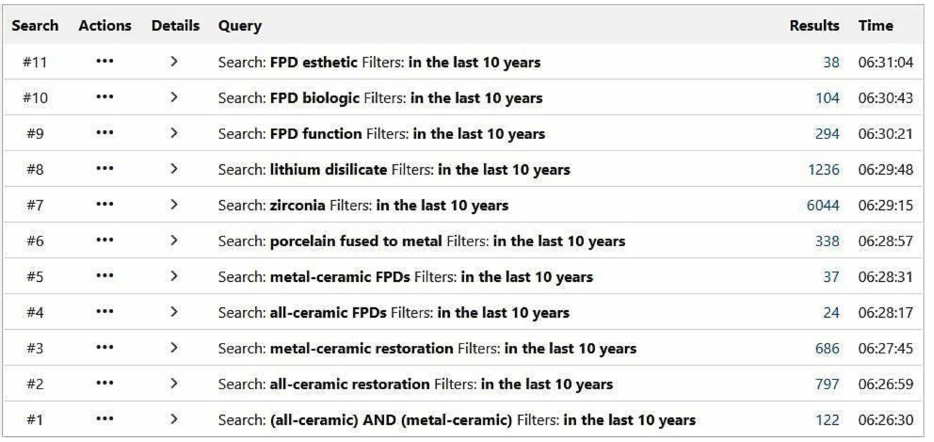
Figure 1. Search terms from